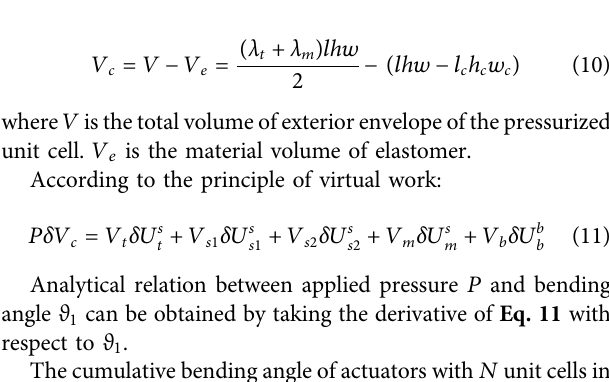
FIGURE 3 | 3D and cross-section view of pneumatic spar with cuboid chambers. Red color denotes the pressurized chambers, and blue color denotes the unpressurized chambers.